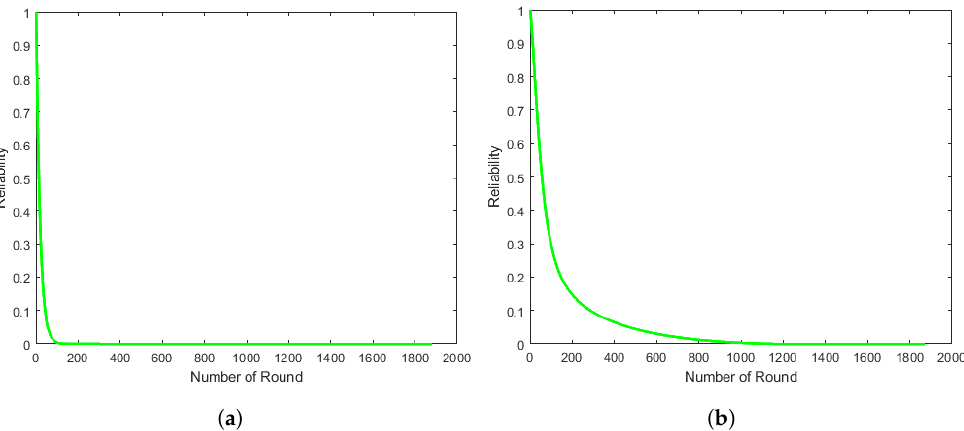
Figure 19. Single-chain stationary CH energy reliability-based proposed RBD: ( a ) D-Chain, ( b ) Q-Chain.